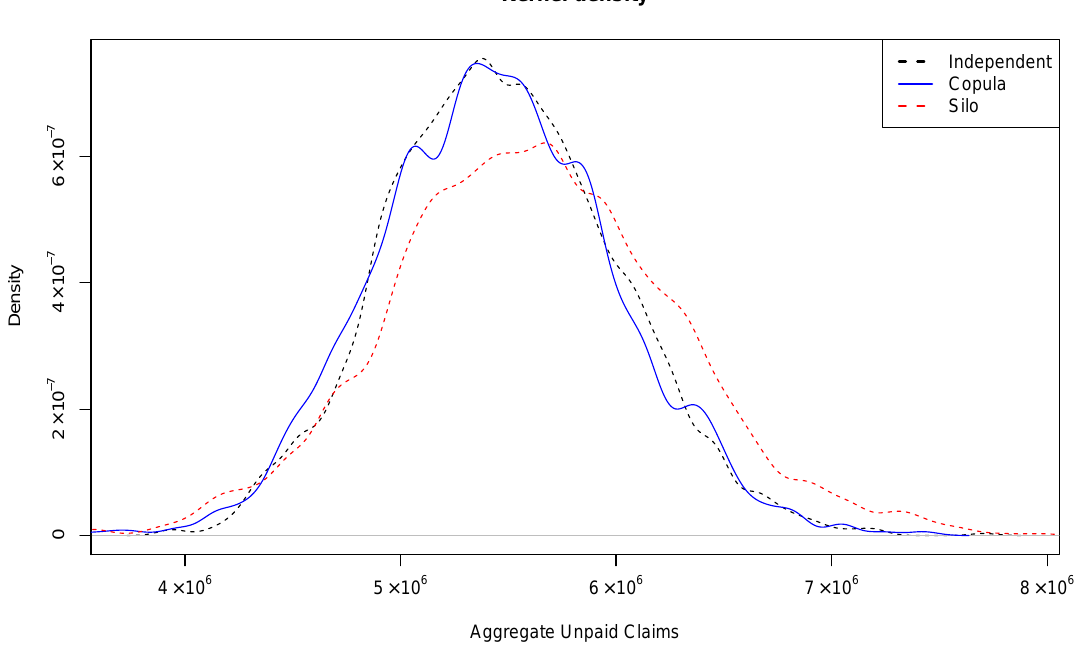
Figure 4. Predictive density of aggregate unpaid claims for constrained